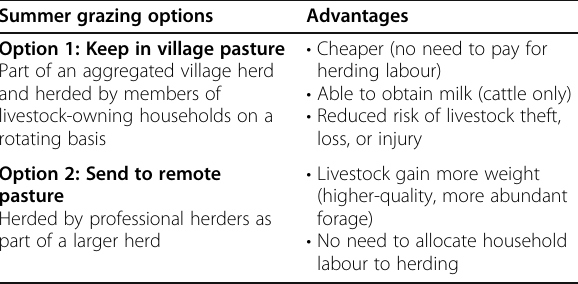
Table 2 Summer grazing options for local herders in Rasht Valley Summer grazing options